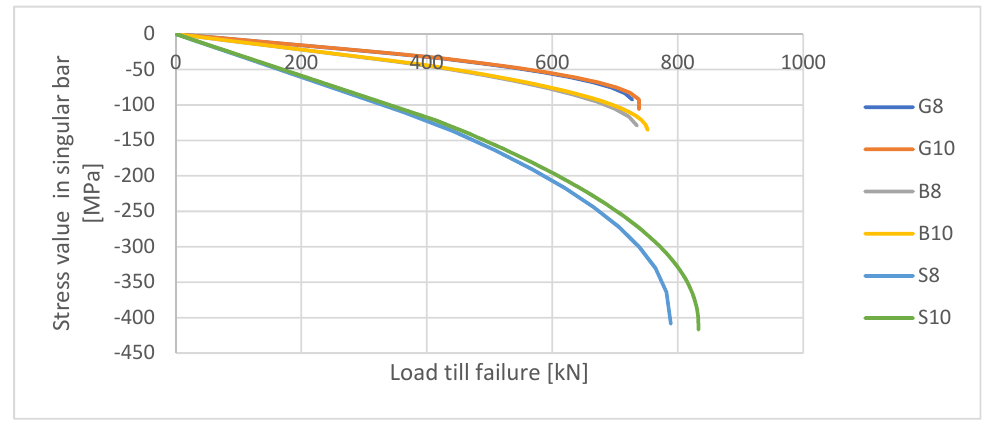
Figure 7. Stress values in singular bars were calculated in ABAQUS (FEM).